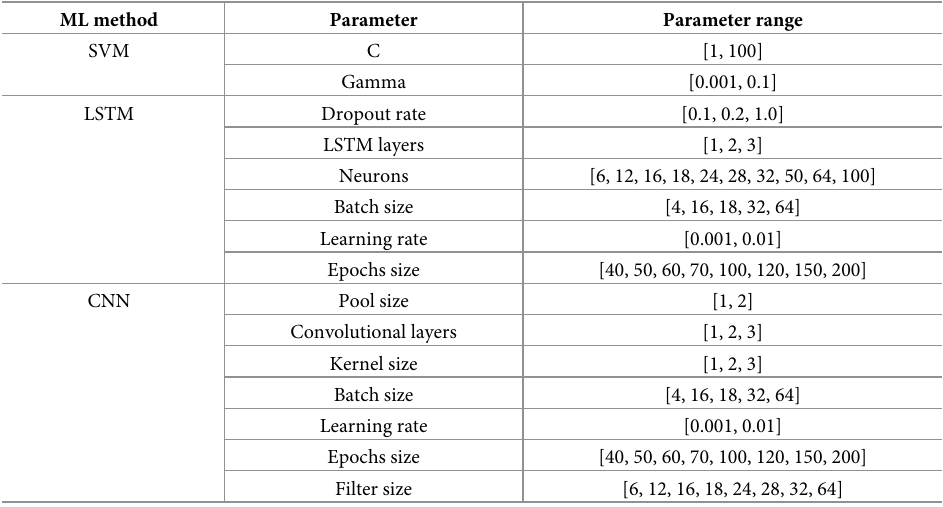
Table 1. Experiment parameters and corresponding value